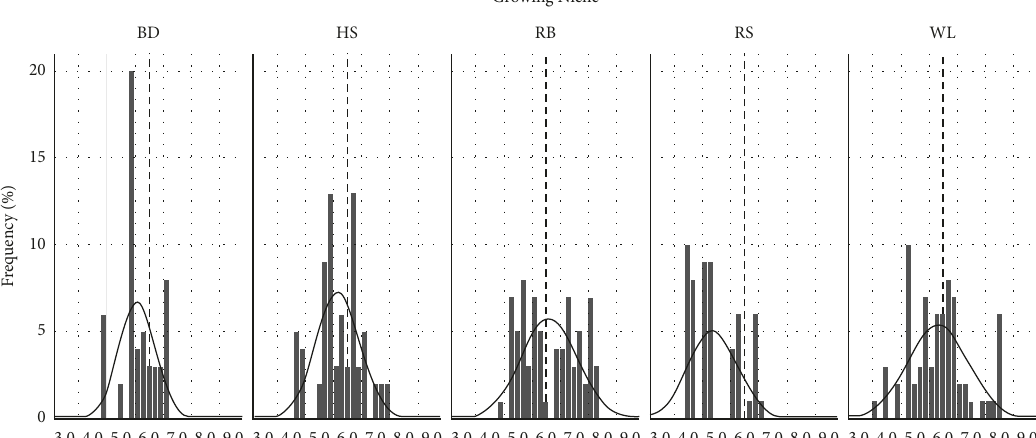
Figure 3: Diameter distribution of bamboo culms (BD � boundary; HS � homestead; RB � river bank; RS � roadside; WL � woodlot plantation